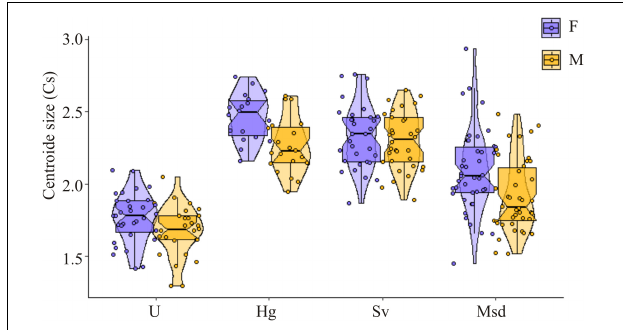
FIGURE 3 | Thorax size variation among landscapes for T. dimidiata female (F) and male (M). Landscape: Urban (U), Homegarden (Hg), Median subdeciduous tropical forest (Msd), and Secondary vegetation